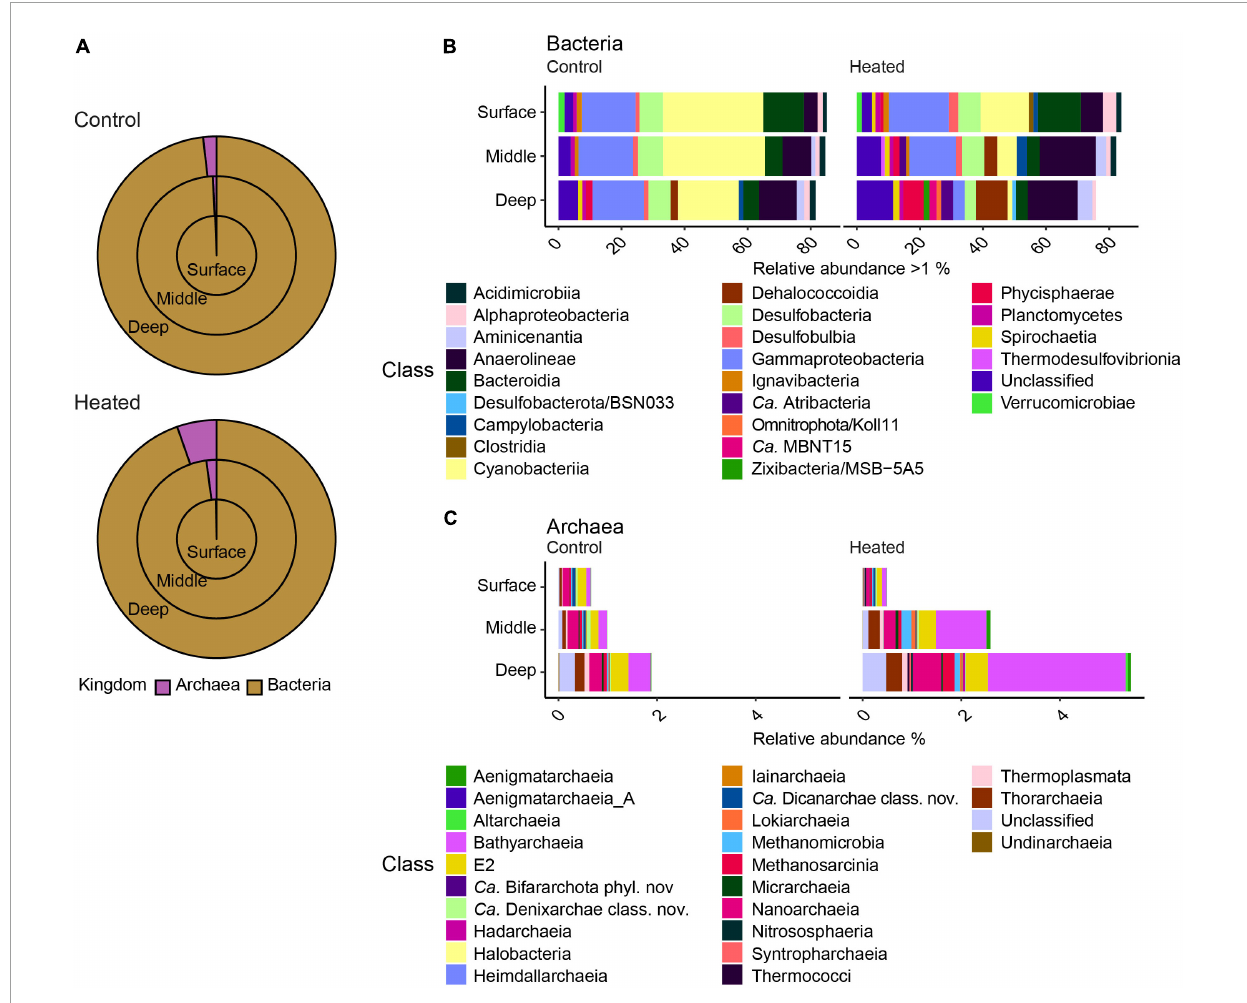
FIGURE3 Relative abundances of bacteria and archaea from the two bays at the three sediment sampling depths showing the surface (outer circle), middle (middle circle), and deep (inner circle) communities (A) along with stacked bar graphs of bacteria (B) with > 1% relative abundance and archaea (C) on the class level for the different sampling depths in the two